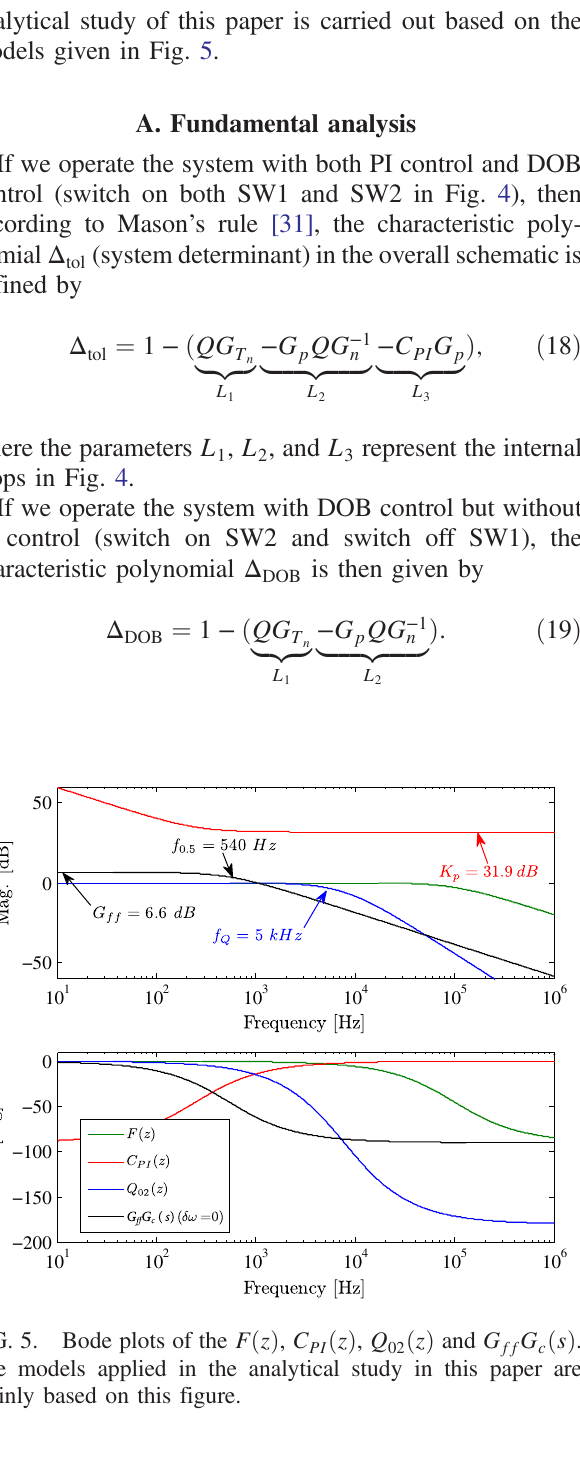
FIG. 5. Bode plots of the F ð z Þ , C The models applied in the analytical study in this paper are mainly based on this